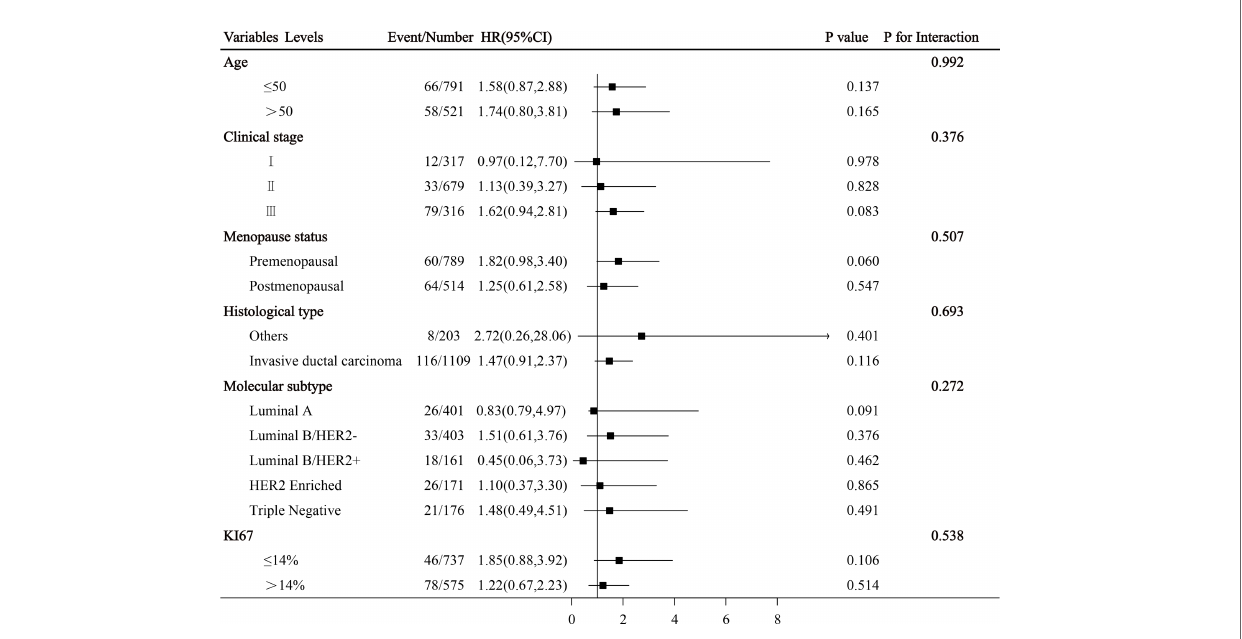
Supplementary Figure 1 | The optimal cut-off of PIV for overall survival in the whole cohort by using maximally selected rank statistics. Supplementary Figure 2 | The forest plot of the results of multivariable regression analysis. Supplementary Figure 3 | Kaplan-Meier survival curves with breast cancer after surgery between the high-PIV group and low-PIV group (A) in the training set and (B) in the validation set. Supplementary Figure 4 | Time-dependent ROC curve compared with PIV and the TNM staging system.